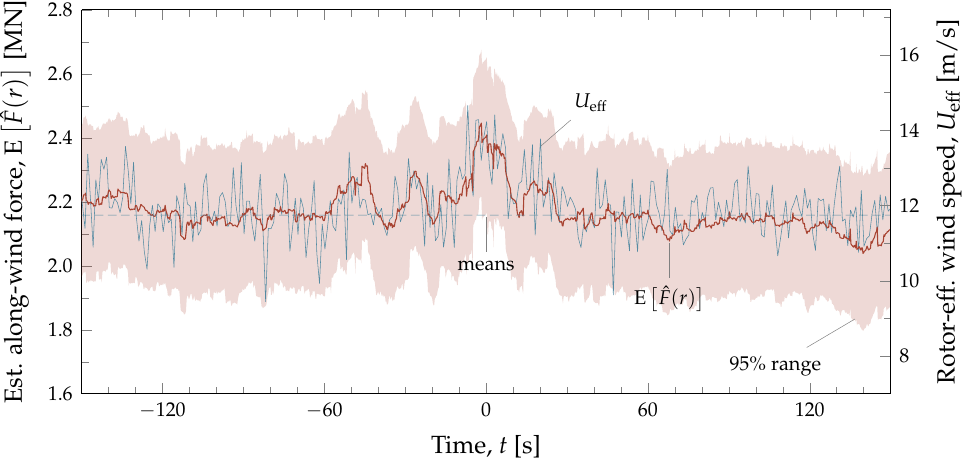
Figure 7. Comparison of the along-wind force forecasted with lidar (including a 10.5 s delay to account for steady advection from r = − 140 m to r = 0 m with ¯ u = 13.3 m/s) and the rotor-effective wind speed derived from the turbine shaft torque (downsampled to 1 Hz for